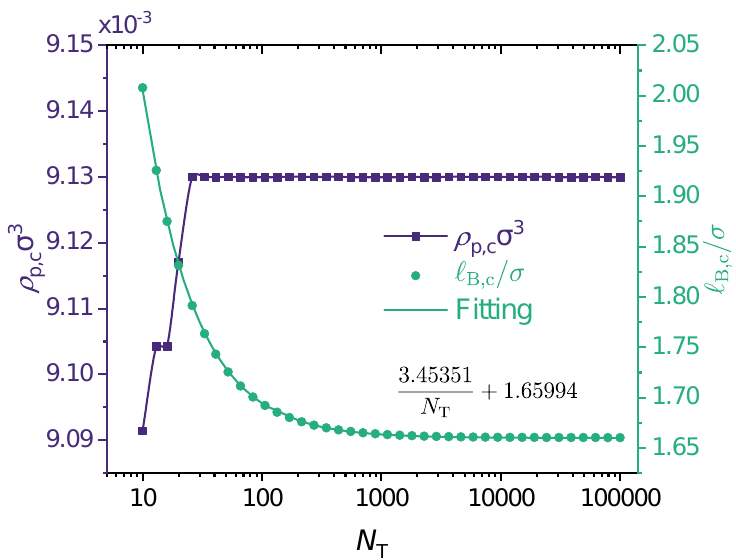
Figure 7. Effect of chain length: concentration of polymer ρ p,c (left y-axis) and Bjerrum length (cid:96) B,c (right y-axis) of critical points in the binodal curves from the GUI App presented in this work. The values for the following parameters were fixed: (cid:101) AC = (cid:101) A = (cid:101) B = 0, Z A = − 1, Z C = + 2, η = 1. Values for N T is were varied, therefore, N 1 = N T η − 1 was varied. Symbols are numerical